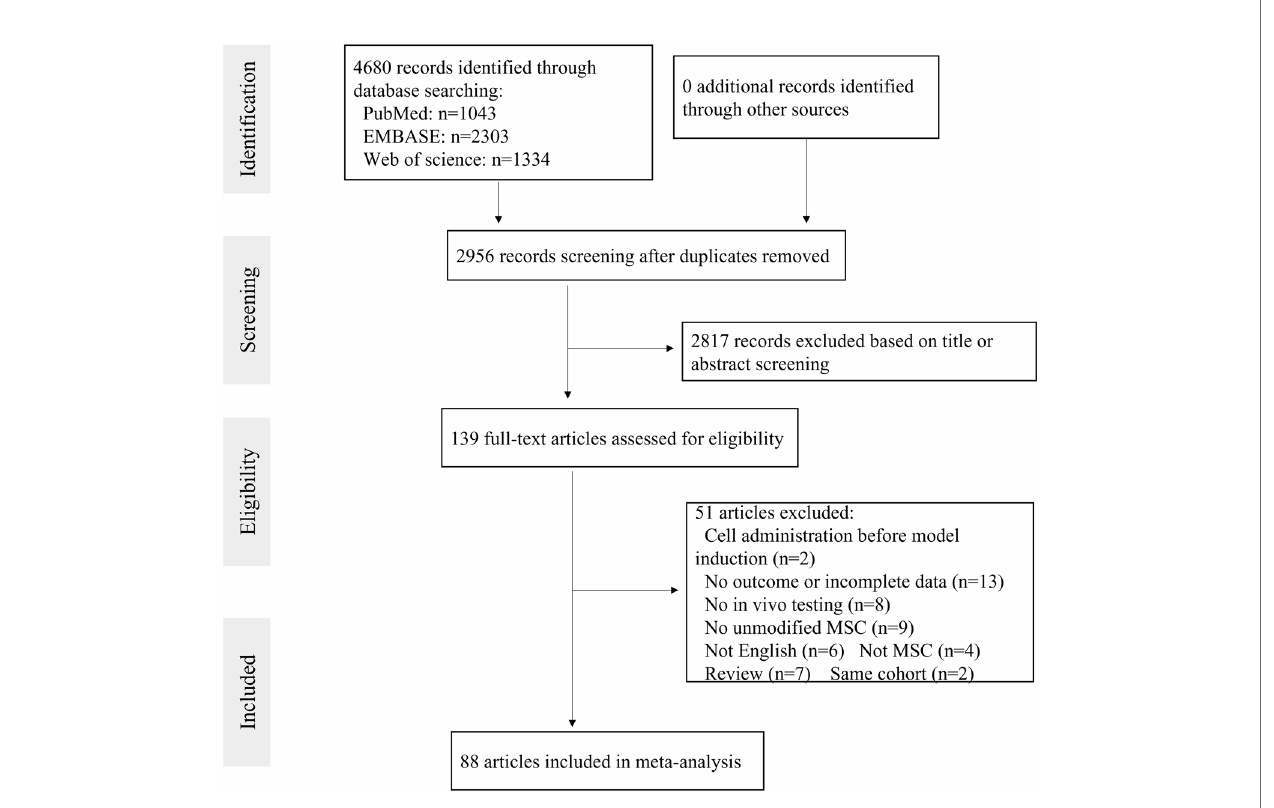
FIGURE 1 | The fl ow diagram describing literature search and study selection.